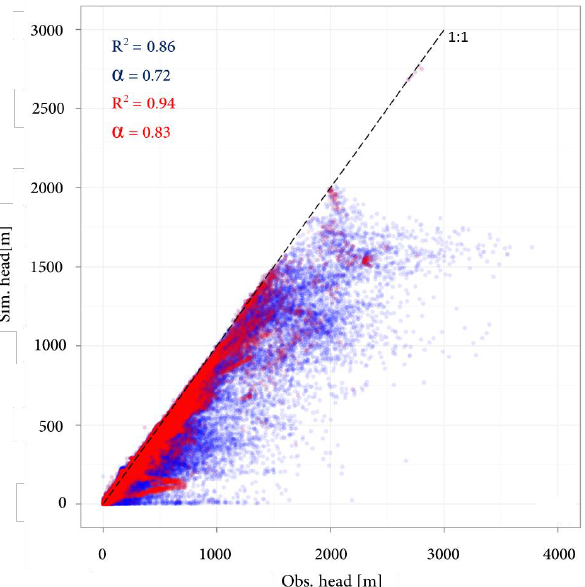
Figure 6. Scatter plot of observed heads against simulated heads for sediment basins (red) and mountain ranges (blue).